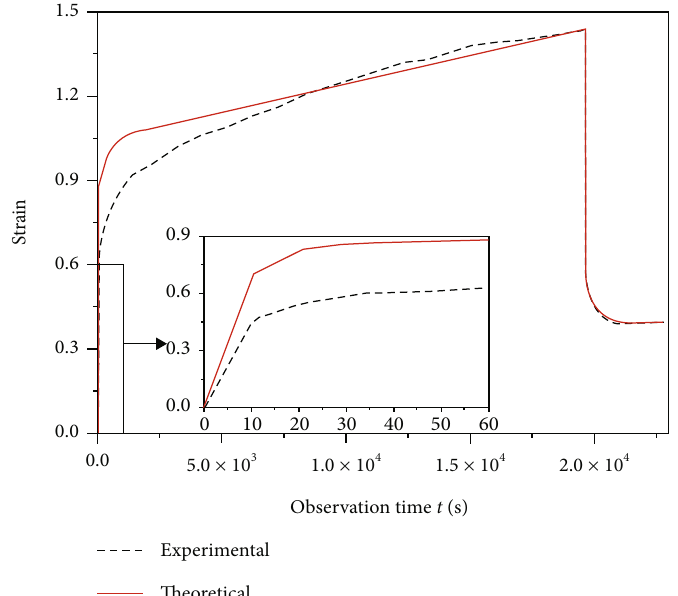
Figure 6: Prediction of the whole creep curve with the parameters evaluated from the recovery curve in Figure 5. In inset: expanded view of the prediction of initial creep